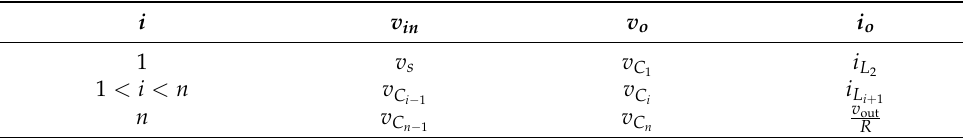
Table 2. The v in , v o and i o in the SS-NS-ZN-HGBC.